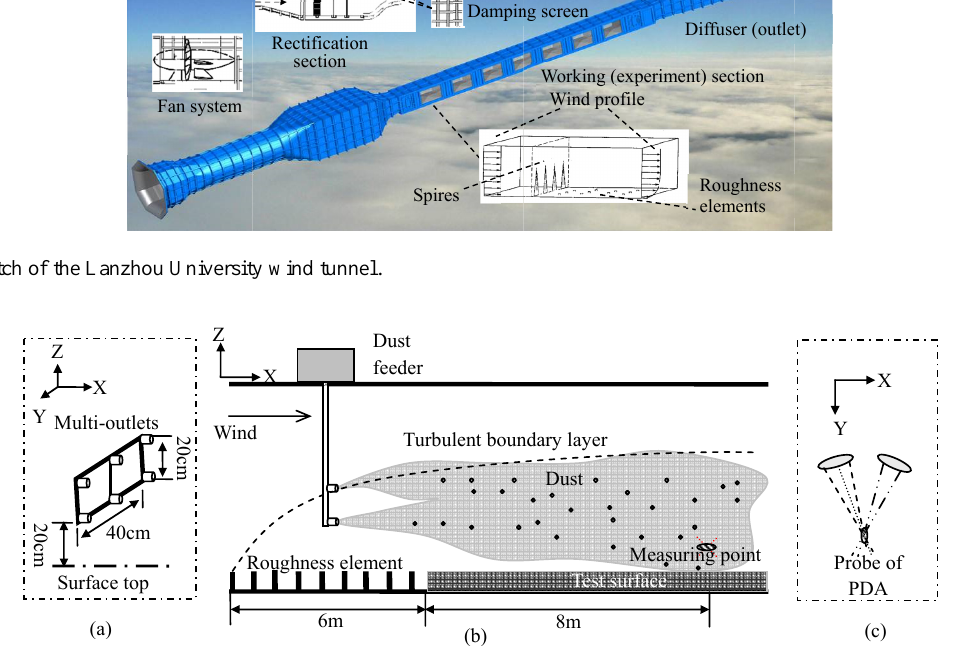
Figure 4. Configuration of the wind-tunnel experiment. (a) Dust feeding outlets; (b) Working section; the roughness elements fixed at the front of the working section generate a deep (at least 0.4m) turbulent boundary layer. Downstream of the roughness-element section is the test surface. A dust feeder is placed at the beginning of the working section and injects dust (SiO 2 ) into the tunnel through a tubular manifold. The measuring point is located near the end of the working section; (c) Probe of the PDA with laser beams intersecting at the measuring